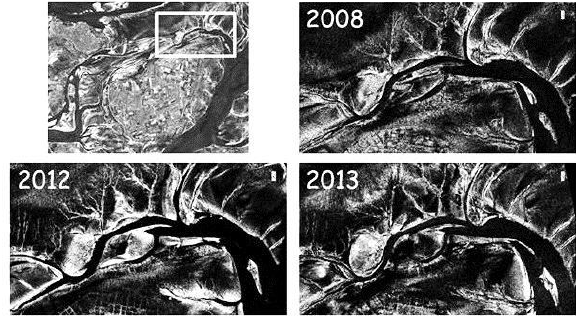
Figure 10. TerraSAR-X images of the “Pellworm” test site (upper left panel; the island is in the image center, the white rectangle indicates the (4.2 km × 2.3 km) part shown in the other panels). Upper right: July 1, 2008, 17:01 UTC; lower left: October 28, 2012, 05:50 UTC, lower right: May 7, 2013, 17:01 UTC. All images were acquired within a few minutes around low